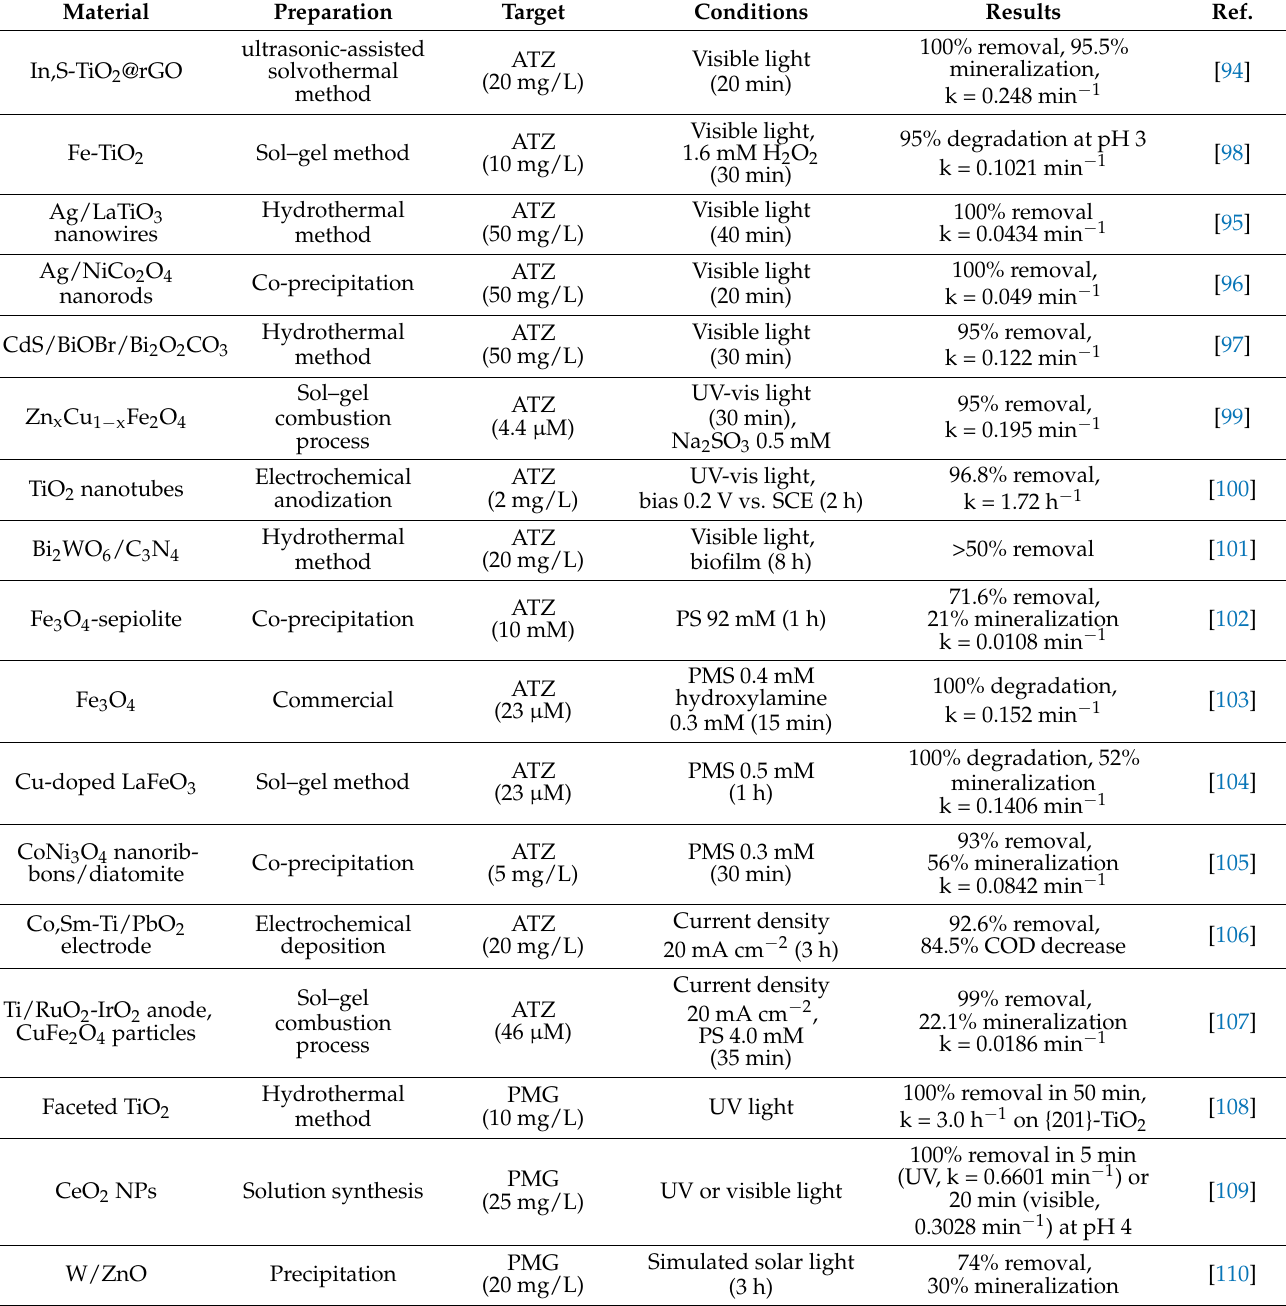
Table 3. Summary of representative metal-oxide-based nanomaterials used for the degradation processes of agricultural chemicals atrazine (ATZ), glyphosate (PMG), paraquat,